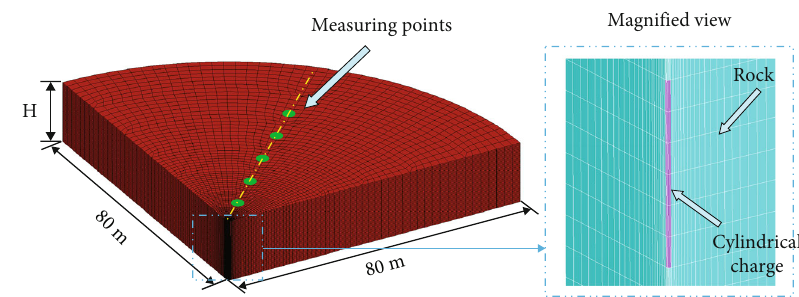
Figure 4: Quarter cylinder fi nite-element